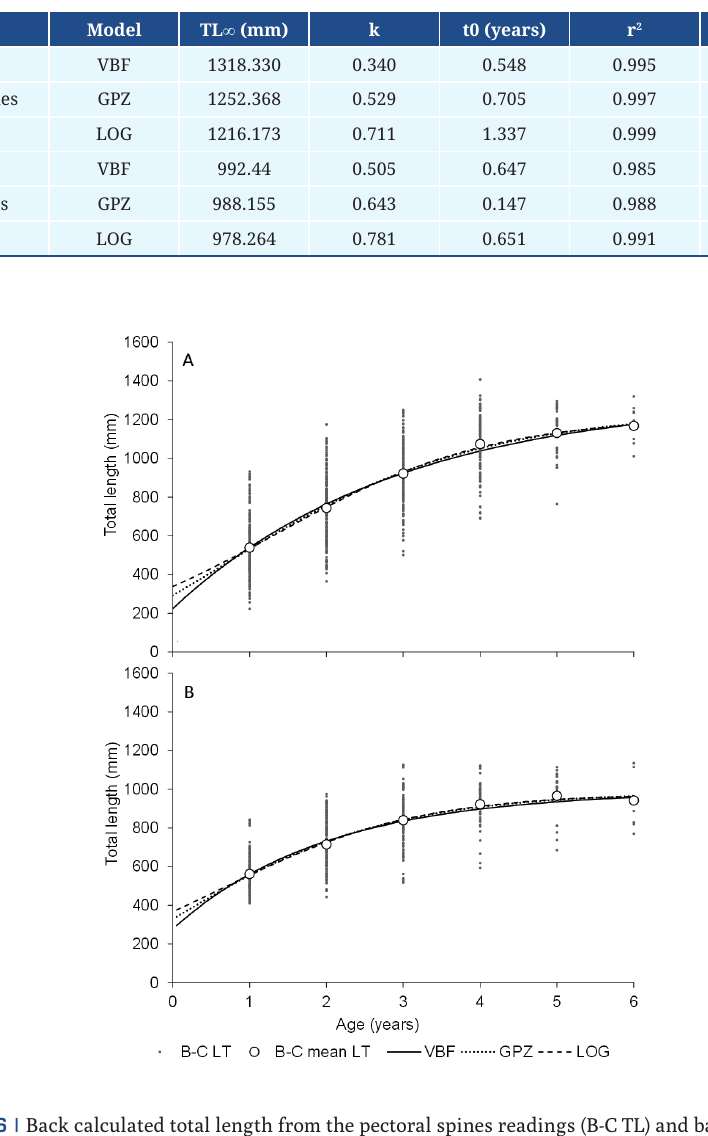
be considered very young for maturity in a big size fish like P. corruscans , however it should be also considered that the estimated ages represent approximations because were